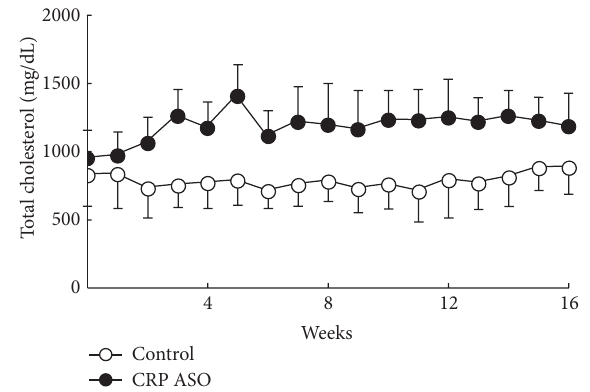
Figure 7: Plasma levels of total cholesterol. Data are combined from male and female rabbits and expressed as the mean ± SD. 𝑛 = 10 for each group.